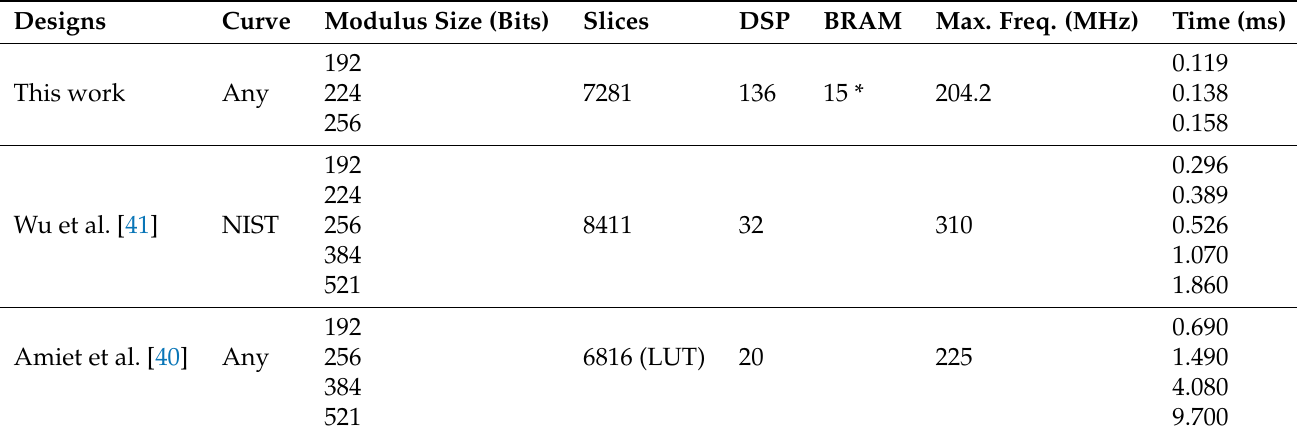
Table 4. Performance comparison of the proposed unified ECC processor for Weierstrass curve up to 256-bit modulus size on Virtex-7